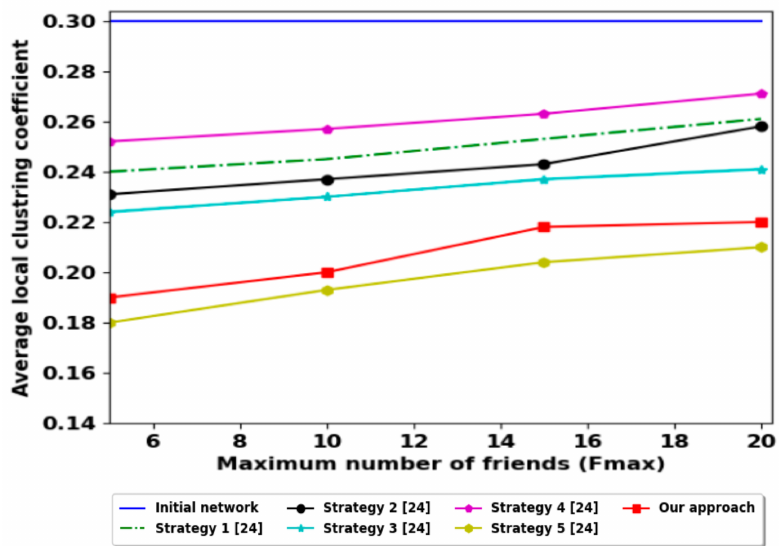
Figure 9. Average local clustering coefficient comparison with other strategies.